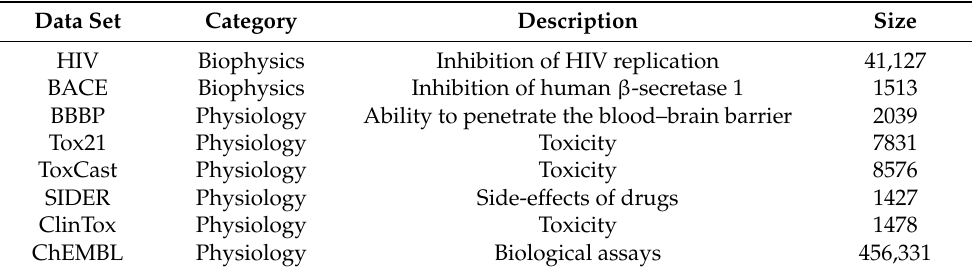
Table 1. Details of the dataset